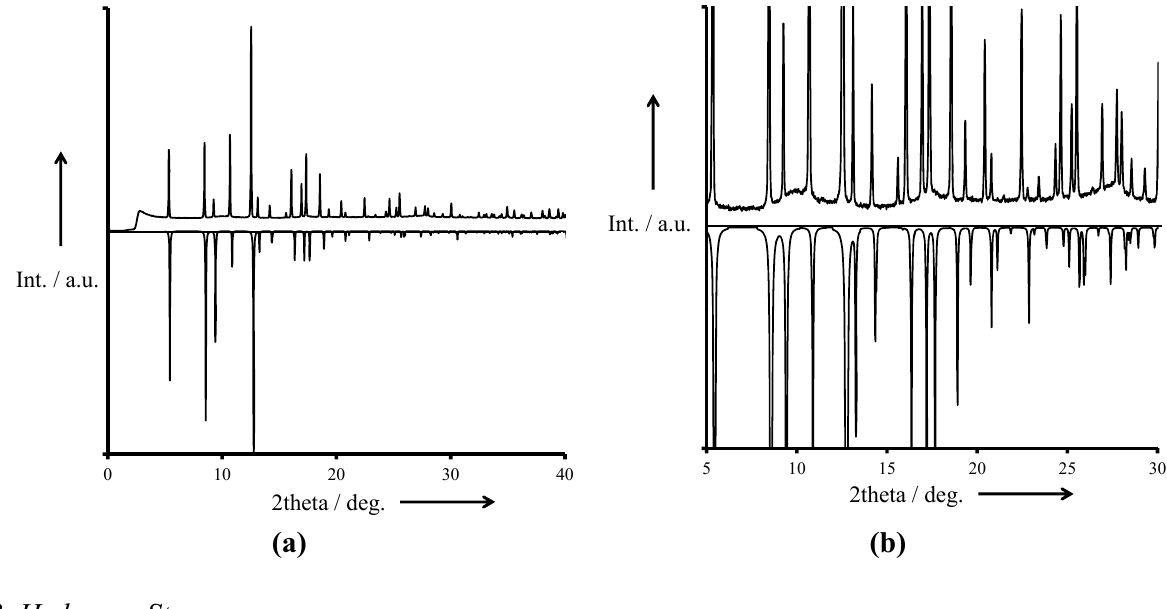
Figure 3. XPRD spectrum of synthesized Cu PDC crystals. ( a ) (Top) Diffraction pattern 2 2 measured by SPring-8. (Bottom) Simulated pattern. FWHM = 0.05. λ = 1.54056 Å; ( b ) Highly magnified image of the low intensity area of (a). Slight differences in peak positions are caused by differences in the lattice parameters between the actual crystal and a model crystal optimized by an LDA calculation [17-20]. Measured peaks show a nearly one-to-one correspondence with the simulated